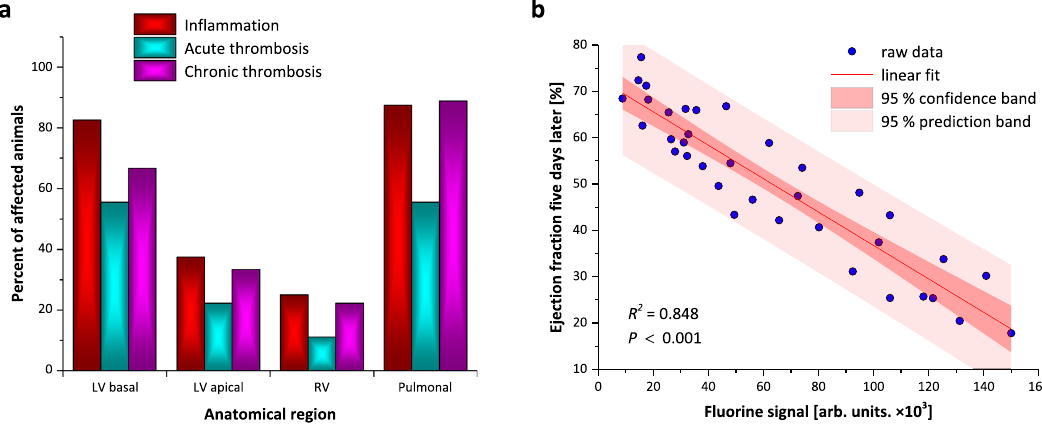
Fig. 5 Occurrence, distribution, and prognostic value of detected 19 F signals. a Occurrence and distribution of detected danger patterns are expressed as percentage of animals affected by in fl ammation (red), acute (cyan) and chronic (magenta) thrombosis in different anatomical regions ( n = 50 in 23/17/10 mice on days 5/10/15; LV, RV = left and right ventricle). b Linear regression analysis for detectable 19 F signal at day x and cardiac function at day x + 5, i.e. the follow-up investigation fi ve days later ( n = 36 in 9/17/10 mice on days 5/10/15, adjusted R 2 = 0.84811, P = 2.926 × 10 − 15 ). The measure of center for the error band is given by the regression line of the linear fi t with y = − 0.0004x + 72.816 and the P value was determined from ANOVA sum of squares. Source data are provided as a source data fi